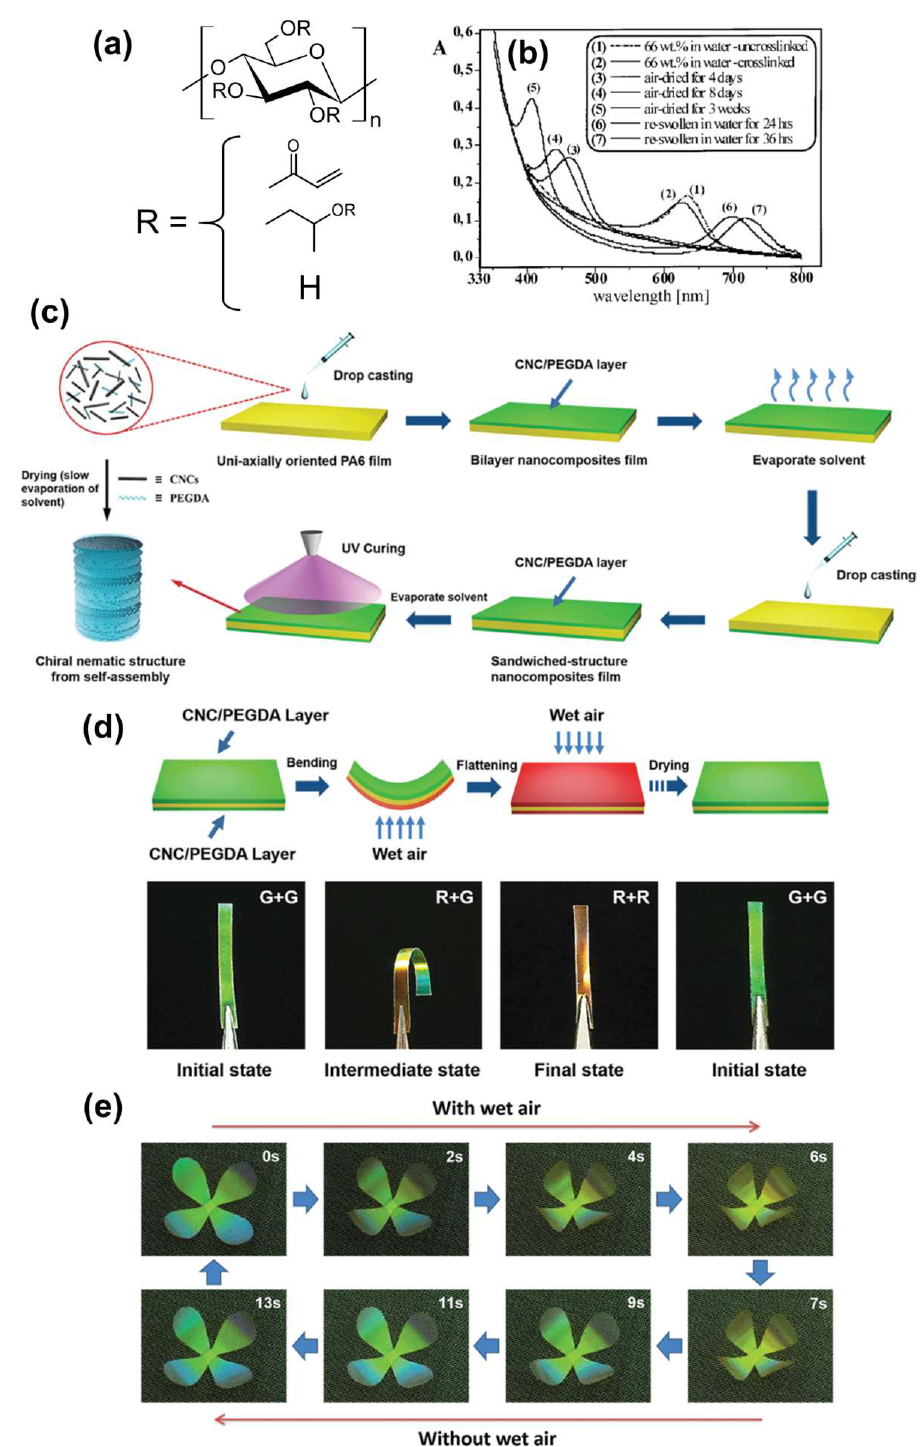
Figure 7. ( a ) Chemical structure of hydroxypropyl cellulose (HPC) acrylate and ( b ) effect of